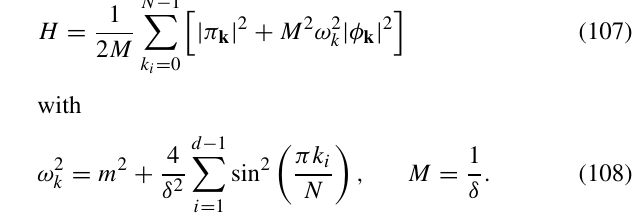
Fig. 10 Illustration of a system of coupled harmonic oscillators obtained by discretizing the scalar field theory on a lattice with spacing δ .Redspringsrepresentcontributionsfromthemass m ofthescalarfield while blue springs introduce couplings between the different oscillators originating from the derivative term in the